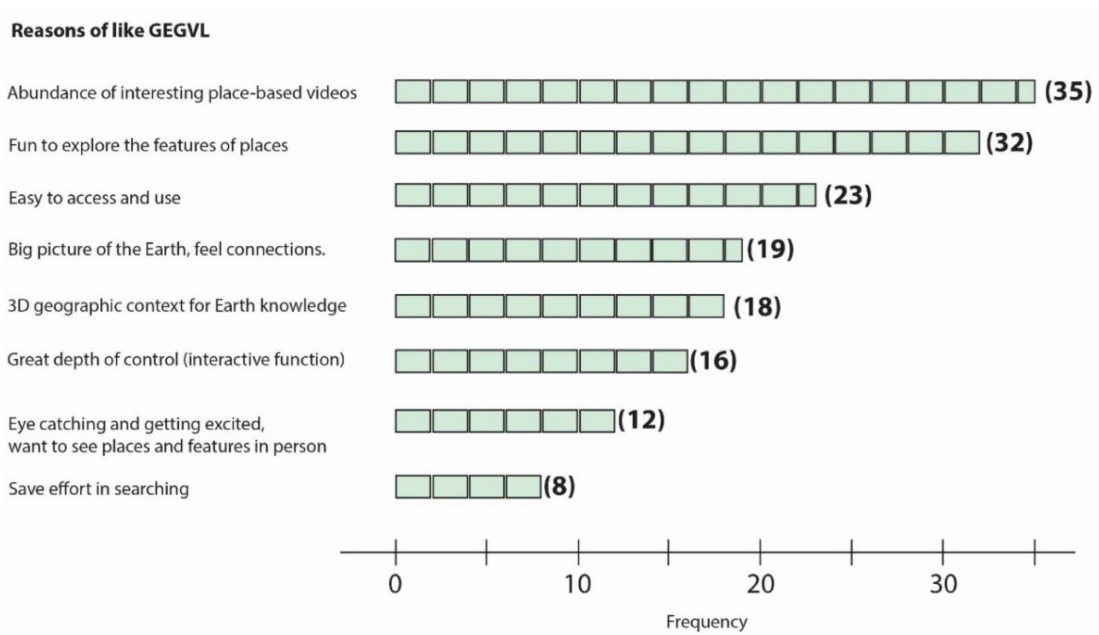
Figure 5. Reasons for liking